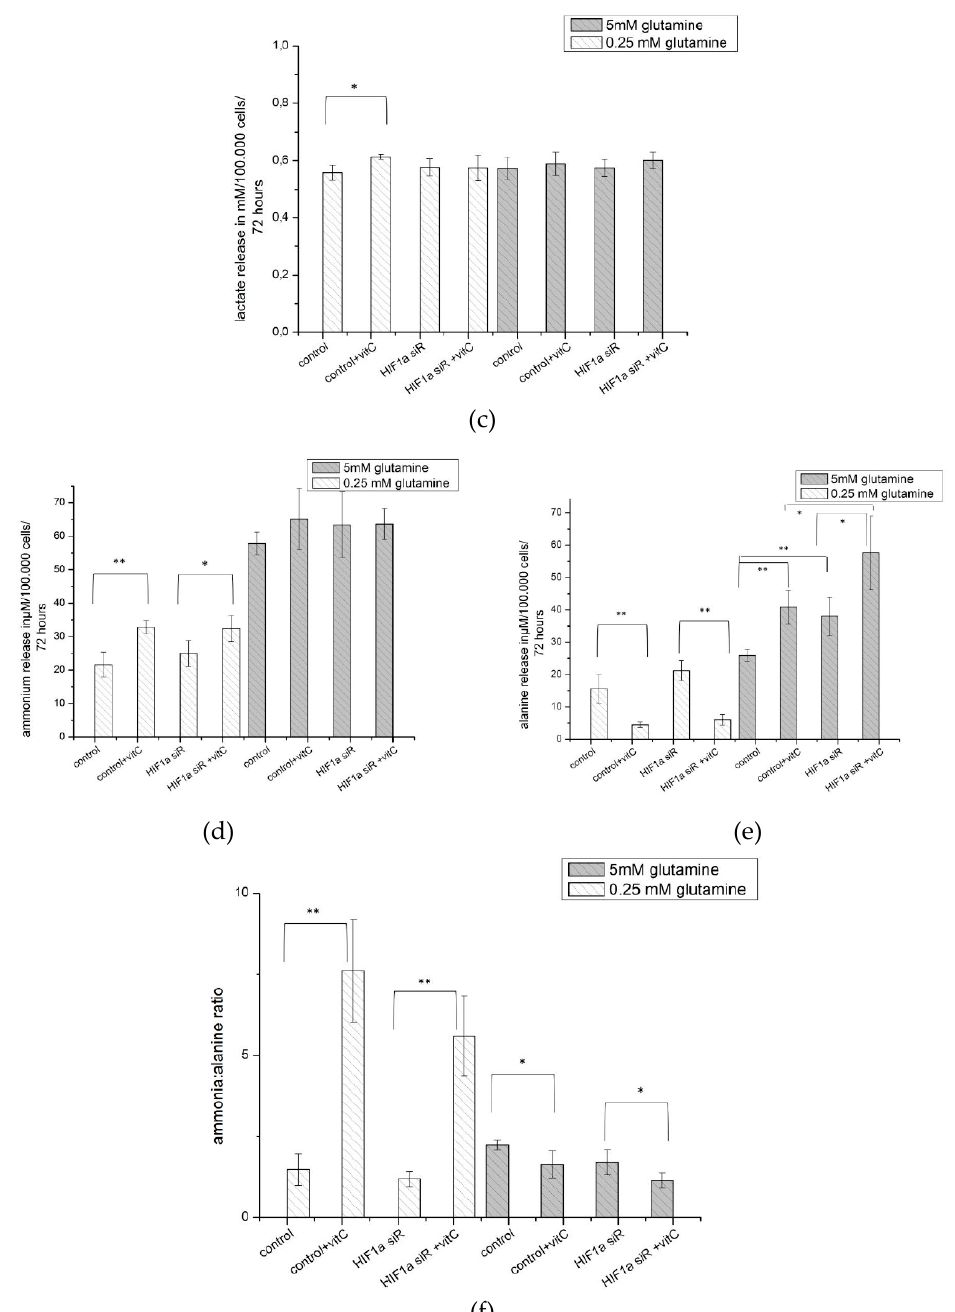
Figure 12. Effect of HIF1 α silencing and/or ascorbic acid on the proliferation and metabolic substances under normoxia ( a , b ) The results from the analysis of the therapeutic effect of ascorbic acid (vitc) in MDA ‐ MB ‐ 231 cells cultivated for 72 h under normoxic conditions with 0.25 mM or 5 mM glutamine and with or without HIF1 α‐ specific siRNA. This experiment was initiated with 200,000 cells. After 72 h of proliferation, the cell number was higher with 5 mM glutamine treatment then it was with 0.25 mM glutamine treatment (see also Figure 11a). At low glutamine levels, the application of ascorbic acid or siRNA against HIF1 α resulted in a very limited reduction of the cell number. At a higher level of glutamine application (5 mM), such an effect could not be found. The uptake of glucose from the medium was approximately 0.3 mM glucose / 100,000 cells and marginally lower compared to the